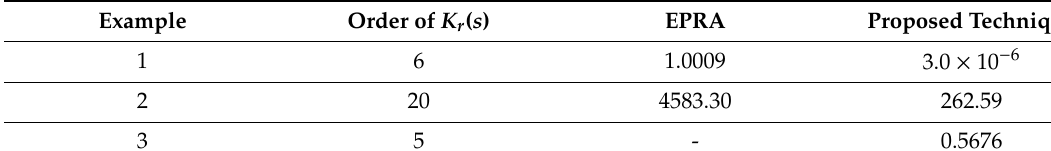
Table 2. Comparison of weighted error W ̅̅̅ 𝑜 (𝑠)[𝐾(𝑠) − 𝐾 𝑟 (𝑠)].